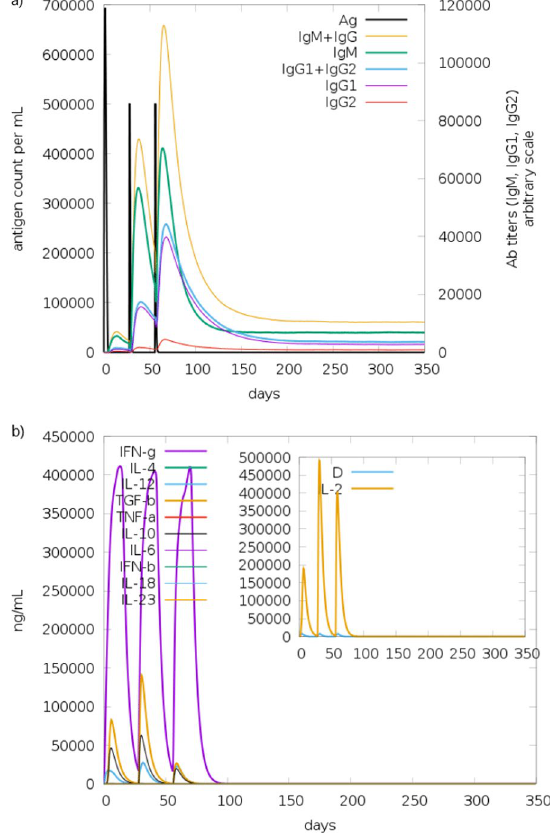
Fig. 12 a Production of several subclasses of immunoglobulin (coloured lines) in response to vaccine injection (black vertical lines) b Production of Cytokine and